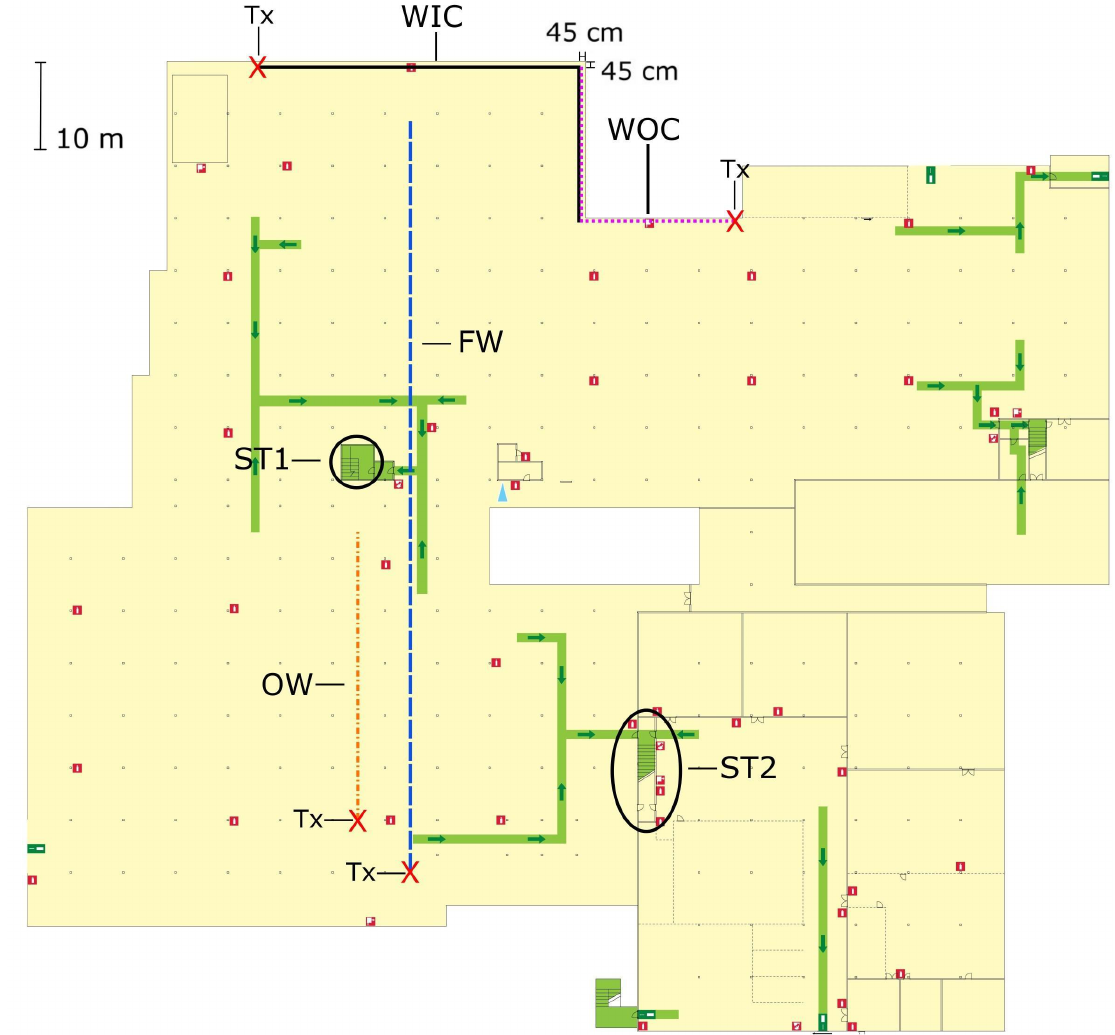
Figure 1. Ground plan of the underground parking garage, showing the different measurement scenarios: dashed blue line: free way (FW), path to and from the parking spots (Figure 2); dash-dotted orange line: obstructed way (OW), path through a line of parked cars (Figure 3); solid black line: along the wall with inside corner (WIC) (Figure 4); dotted purple line: along the wall with outside corner (WOC) (Figure 5); Staircase 1 (ST1, two 90 ◦ turns) (Figure 6); and Staircase 2 (ST2, straight) (Figure 7). Transmitter (Tx) locations are marked by red crosses. The green lines with arrows represent evacuation paths for pedestrians in the case of an emergency. It should be noted that these paths are different from the paths that first responders would use, especially in the case of a fire when a path along the walls would be